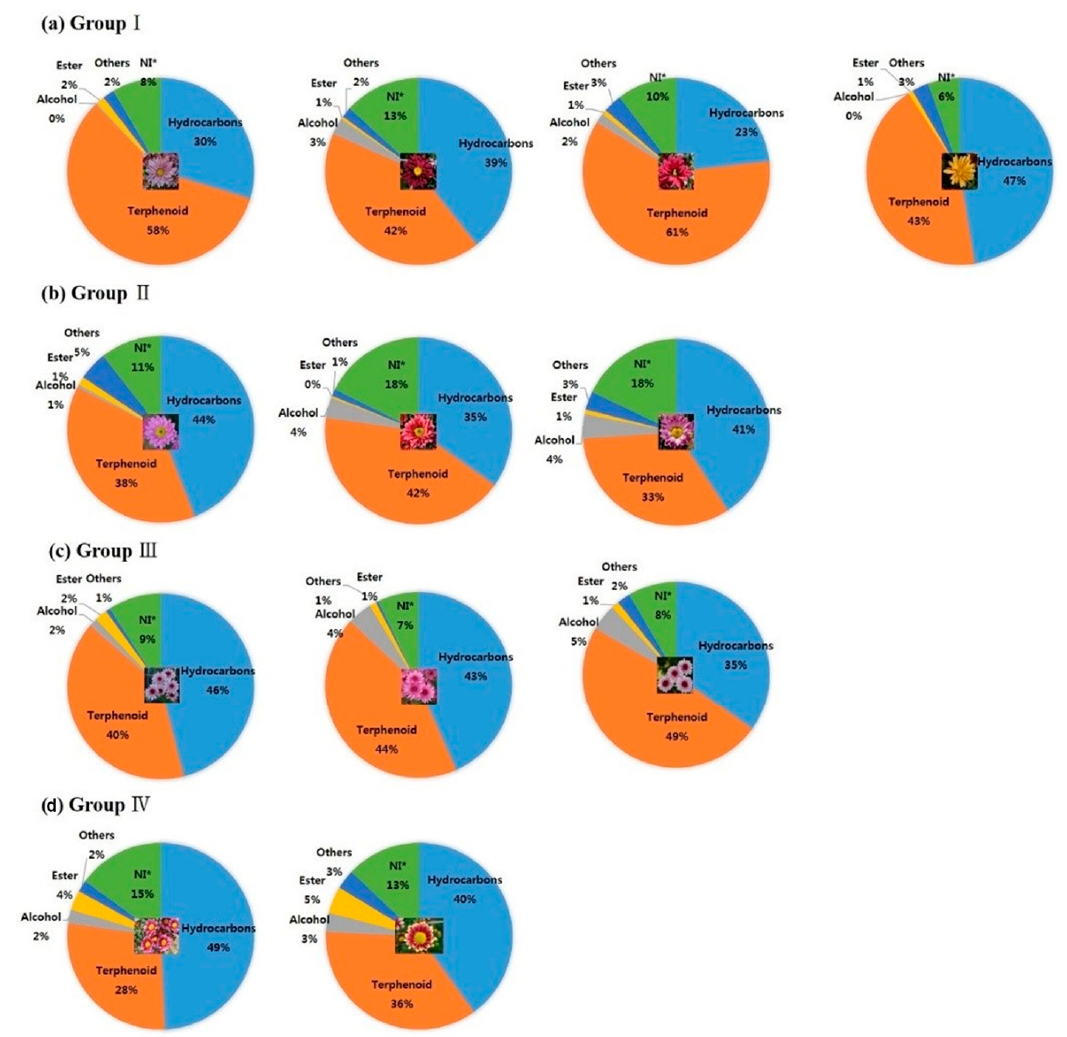
Figure3. Relativecontents(%)ofvolatilecompoundsreleasedfromtheflowersofthe12chrysanthemum cultivars. ( a ) Group I: ‘Noble Wine’, ‘ARTI-Dark Chocolate’, ‘ARTI-Purple Lady’, and ‘ARTI-Yellow Star’; ( b ) Group II: ‘Pinky’, ‘ARTI-Red Star’, and ‘ARTI-Rising Sun’; ( c ) Group III: ‘Argus’, ‘ARTI-Purple’, and ‘ARTI-Queen’; ( d ) Group IV: ‘Plaisir d’amour’ and ‘ARTI-Rollypop’. NI: not